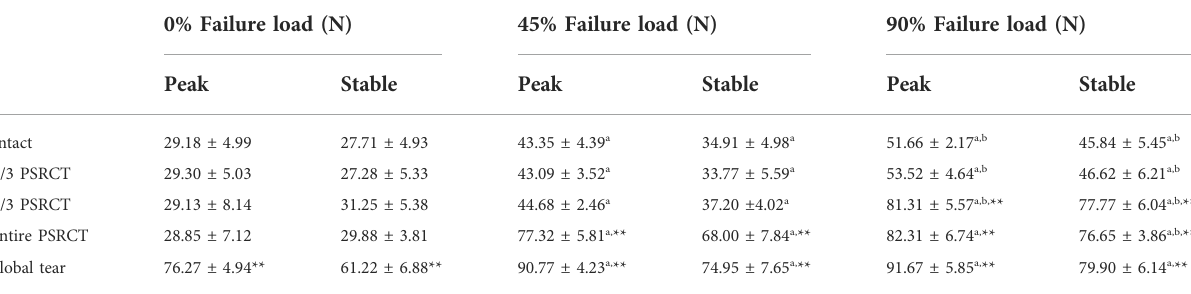
TABLE 1 Effect of RCT on MDF during